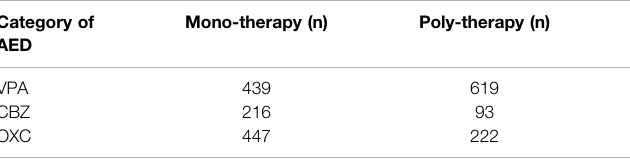
TABLE 5 | AED ef fi cacy in monotherapy and polytherapy